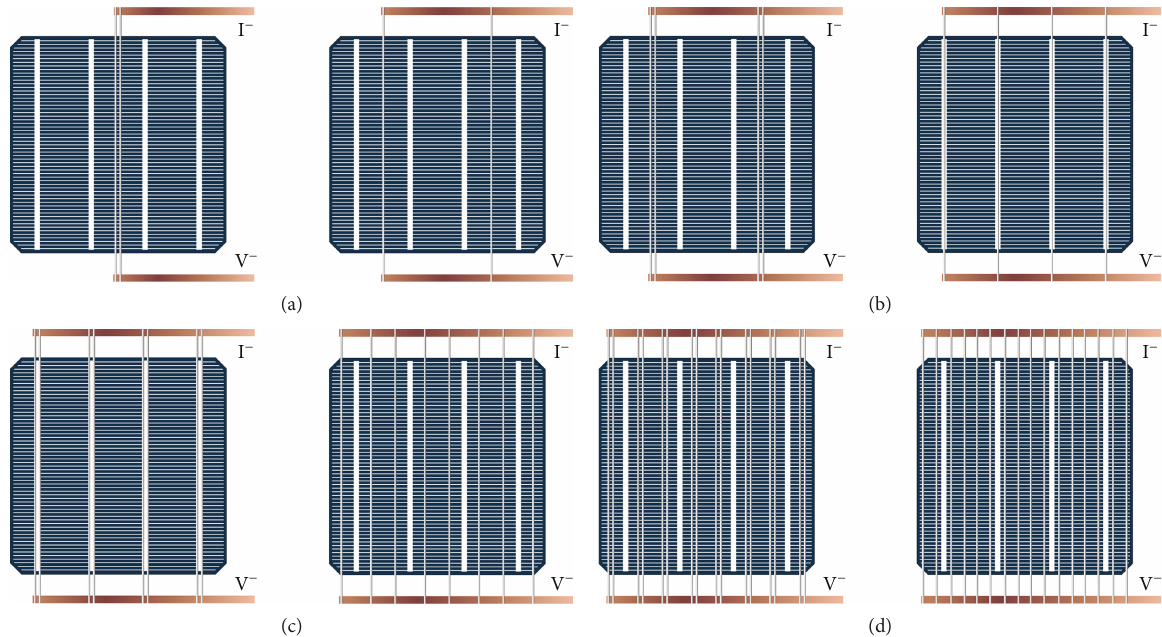
Figure 7: Four groups of module electrode structures were designed to test the fi nger series resistance; each group had two module electrode structures with di ff erent busbar numbers. (a) one and two busbars, (b) two and four busbars, (c) four and eight busbars, and (d) eight and sixteen busbars.